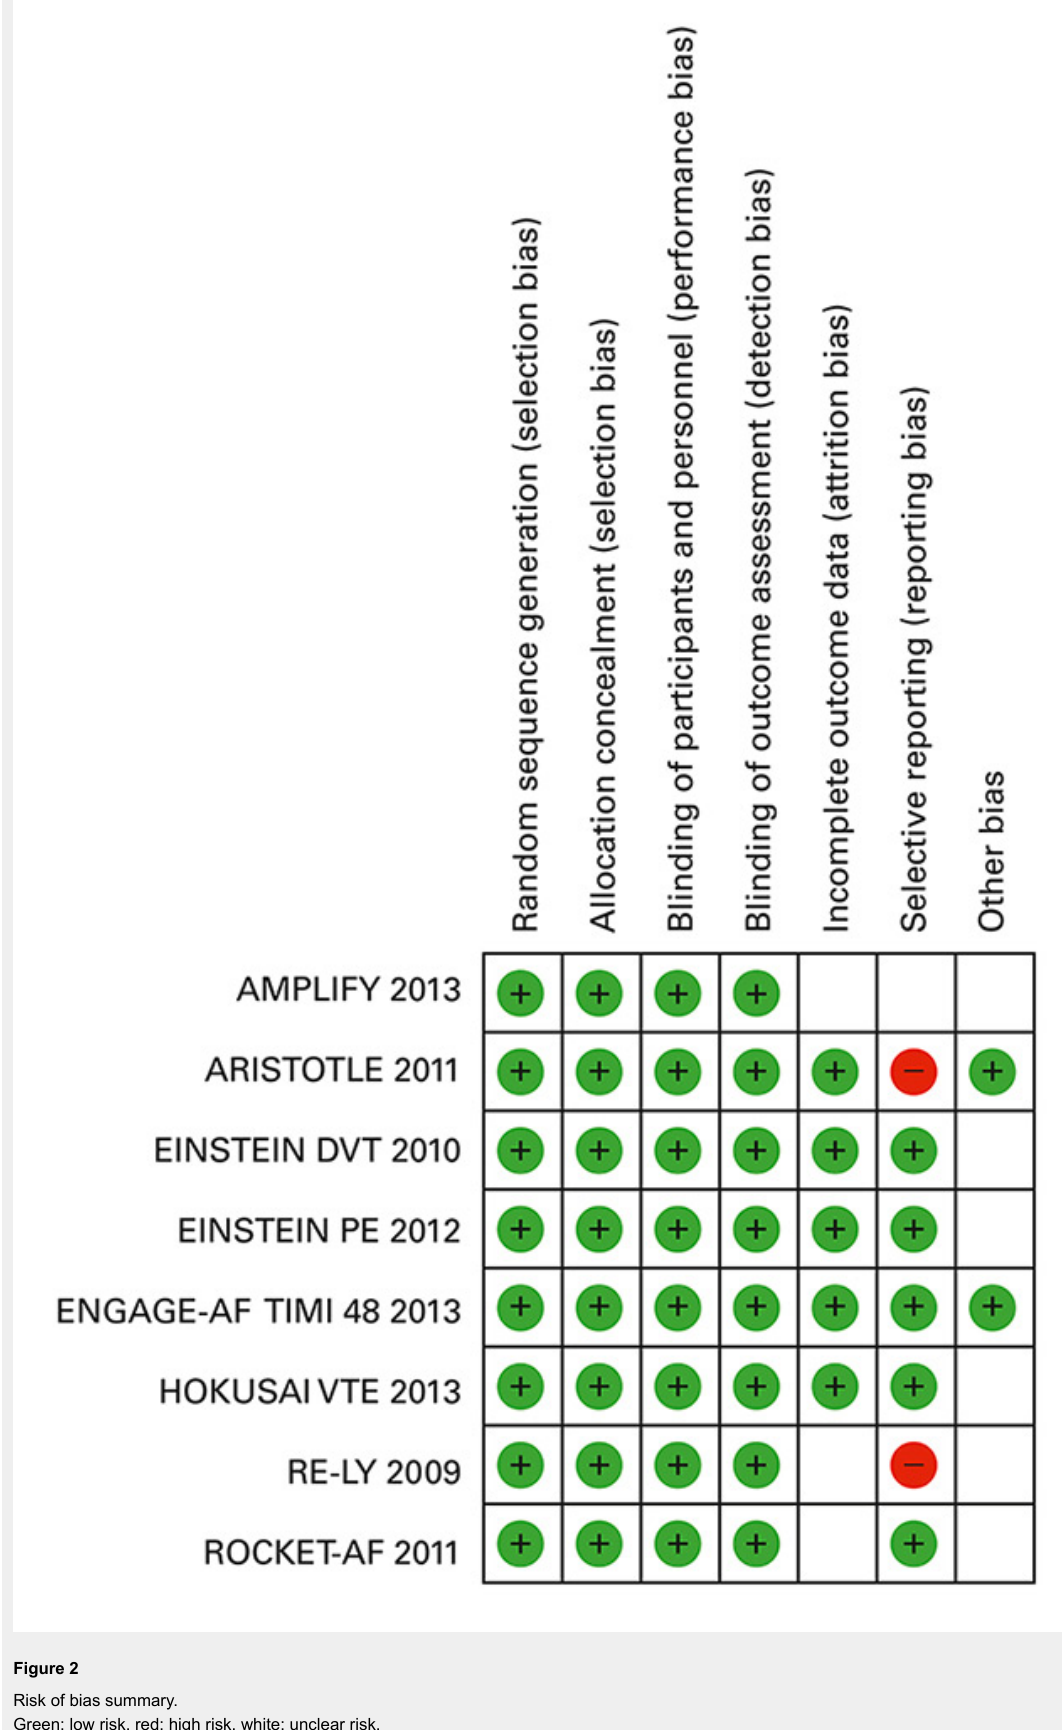
Figure 2 Risk of bias summary. Green: low risk, red: high risk, white: unclear